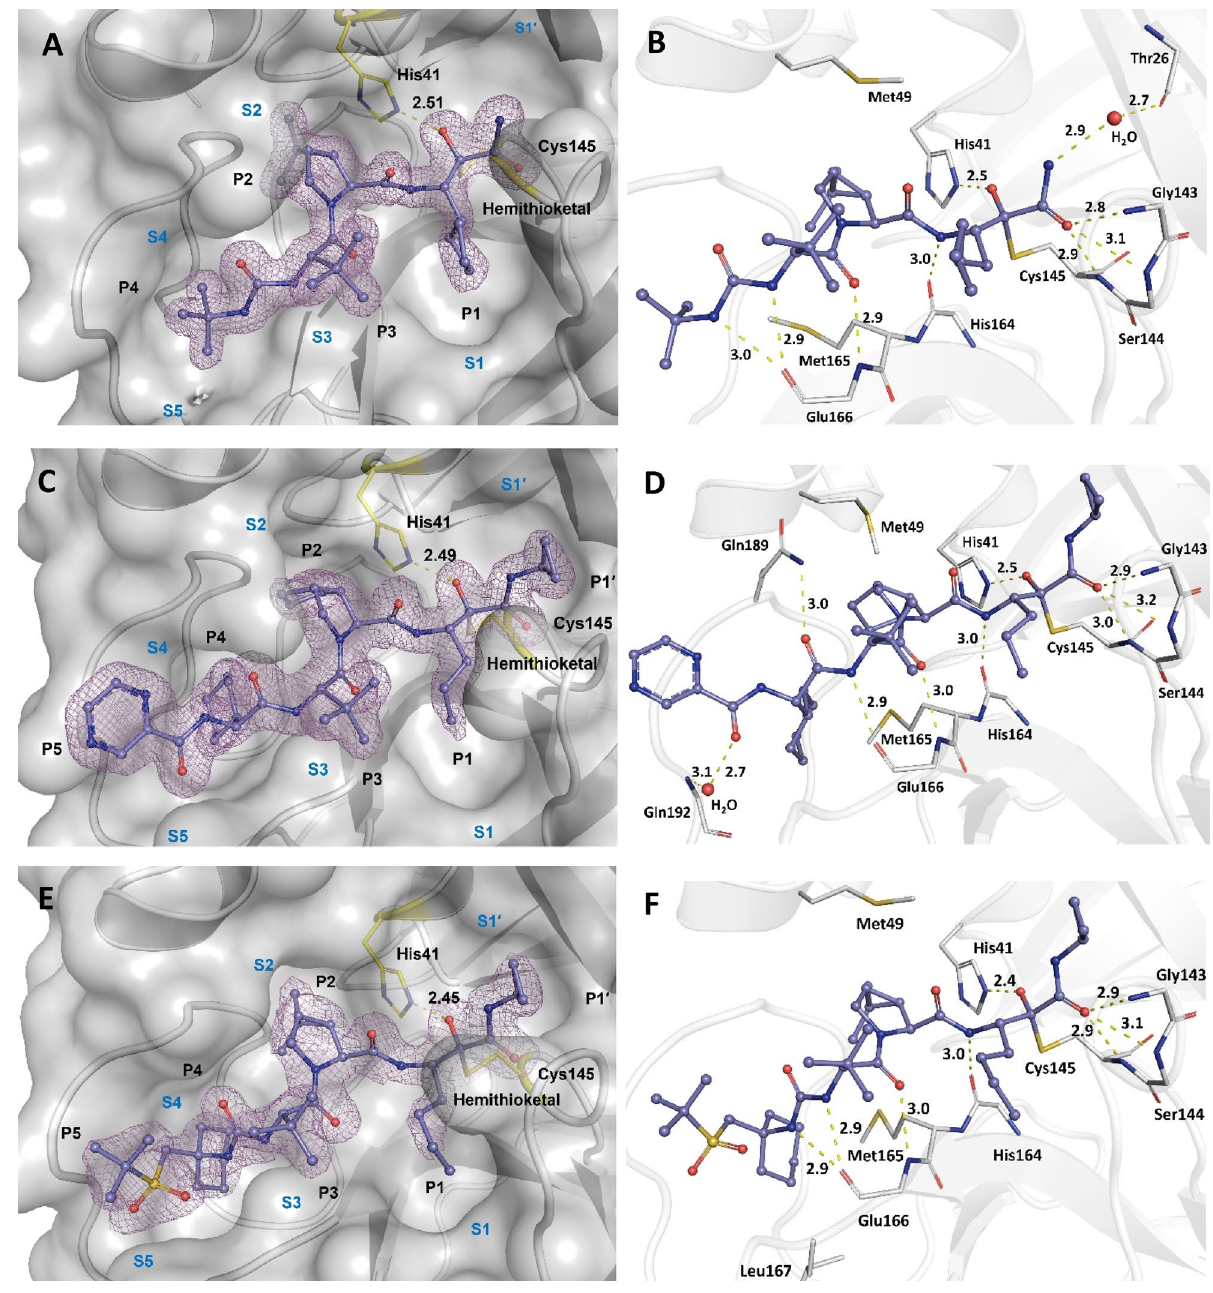
Figure 1. Active subsites of the M pro binding pocket (S1 ′ –S5), ligand functional groups or positions (P1 ′ –P5), and hydrogen bonding interactions of the HCV NS3/4A inhibitors with M pro . ( A ) Electron density of the boceprevir complex at 1.35 Å resolution (PDB entry: 7K40). Boceprevir lacks the P1 ′ and P5 functional groups and therefore the associated enzyme subsites are not occupied. ( B ) Hydrogen bonding interactions of boceprevir complex. One structural water molecule facilitates the binding of the amine group of the α-ketoamide moiety. ( C ) electron density of the telaprevir complex at 1.48 Å resolution (PDB entry: 7K6D). ( D ) Hydrogen bonding interactions of the telaprevir complex. One structural water molecule facilitates the binding of the pyrazine (P5) moiety. ( E ) Electron density of the narlaprevir complex at 1.79 Å resolution (PDB entry: 7JYC). ( F ) Hydrogen bonding interactions of the narlaprevir complex. Ligands are shown as ball-and-stick representation. Electron densities (2F o –F c , 1 rmsd) are shown as purple mesh. All distances are in Å. ( C ) reproduced with permission of the International Union of Crystallography, Acta Cryst. (2021), A77, C194 (https:// doi. org/ 10. 1107/ S0108 76732 10948